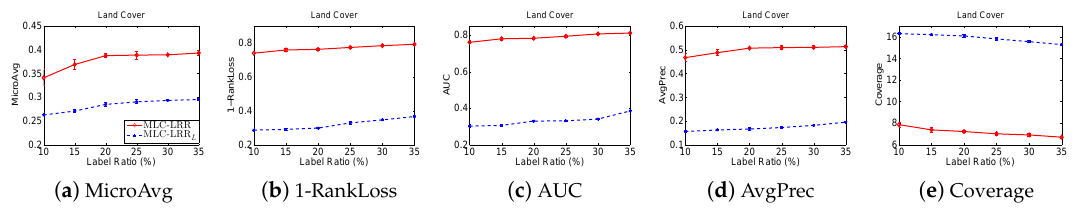
Figure 3. MLC-LRR vs. MLC-LRR evaluation metrics ( a–e